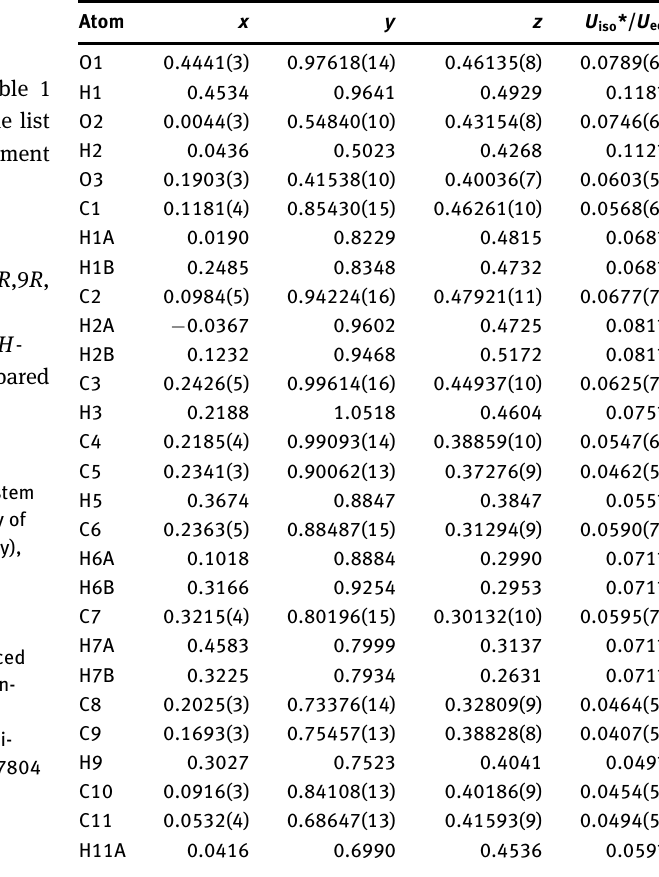
Table 2: Fractional atomic coordinates and isotropic or equivalent isotropic displacement parameters (Å 2